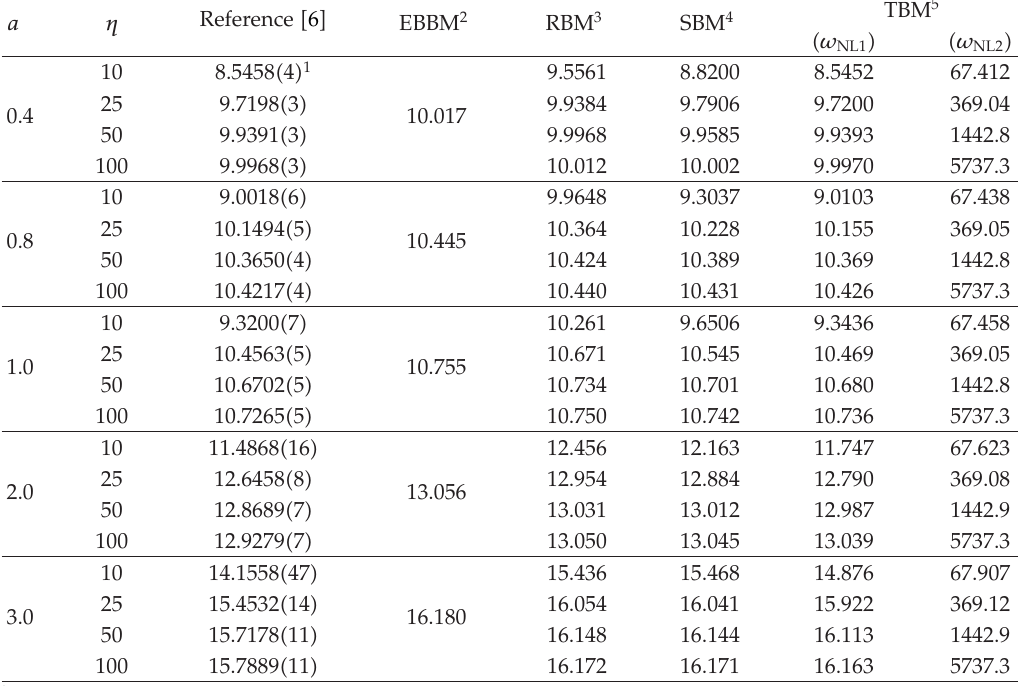
Table 1: Comparison of the nondimensional nonlinear frequency (cid:2) ω NL (cid:3)